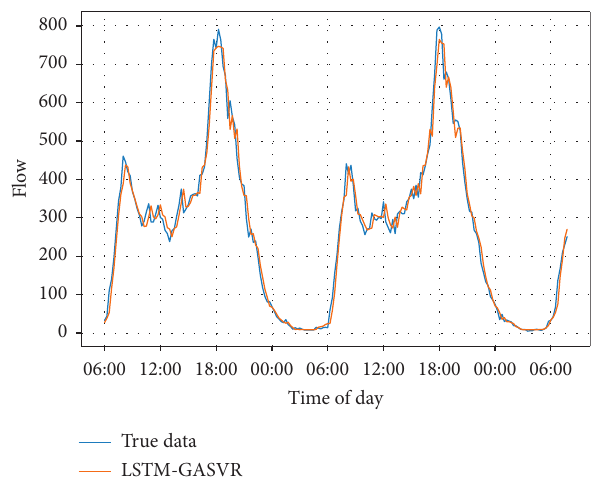
Figure 19: LSTM-GASVR prediction